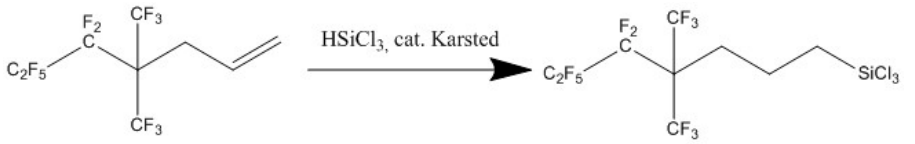
Figure 1. Trichlorosilane addition reaction